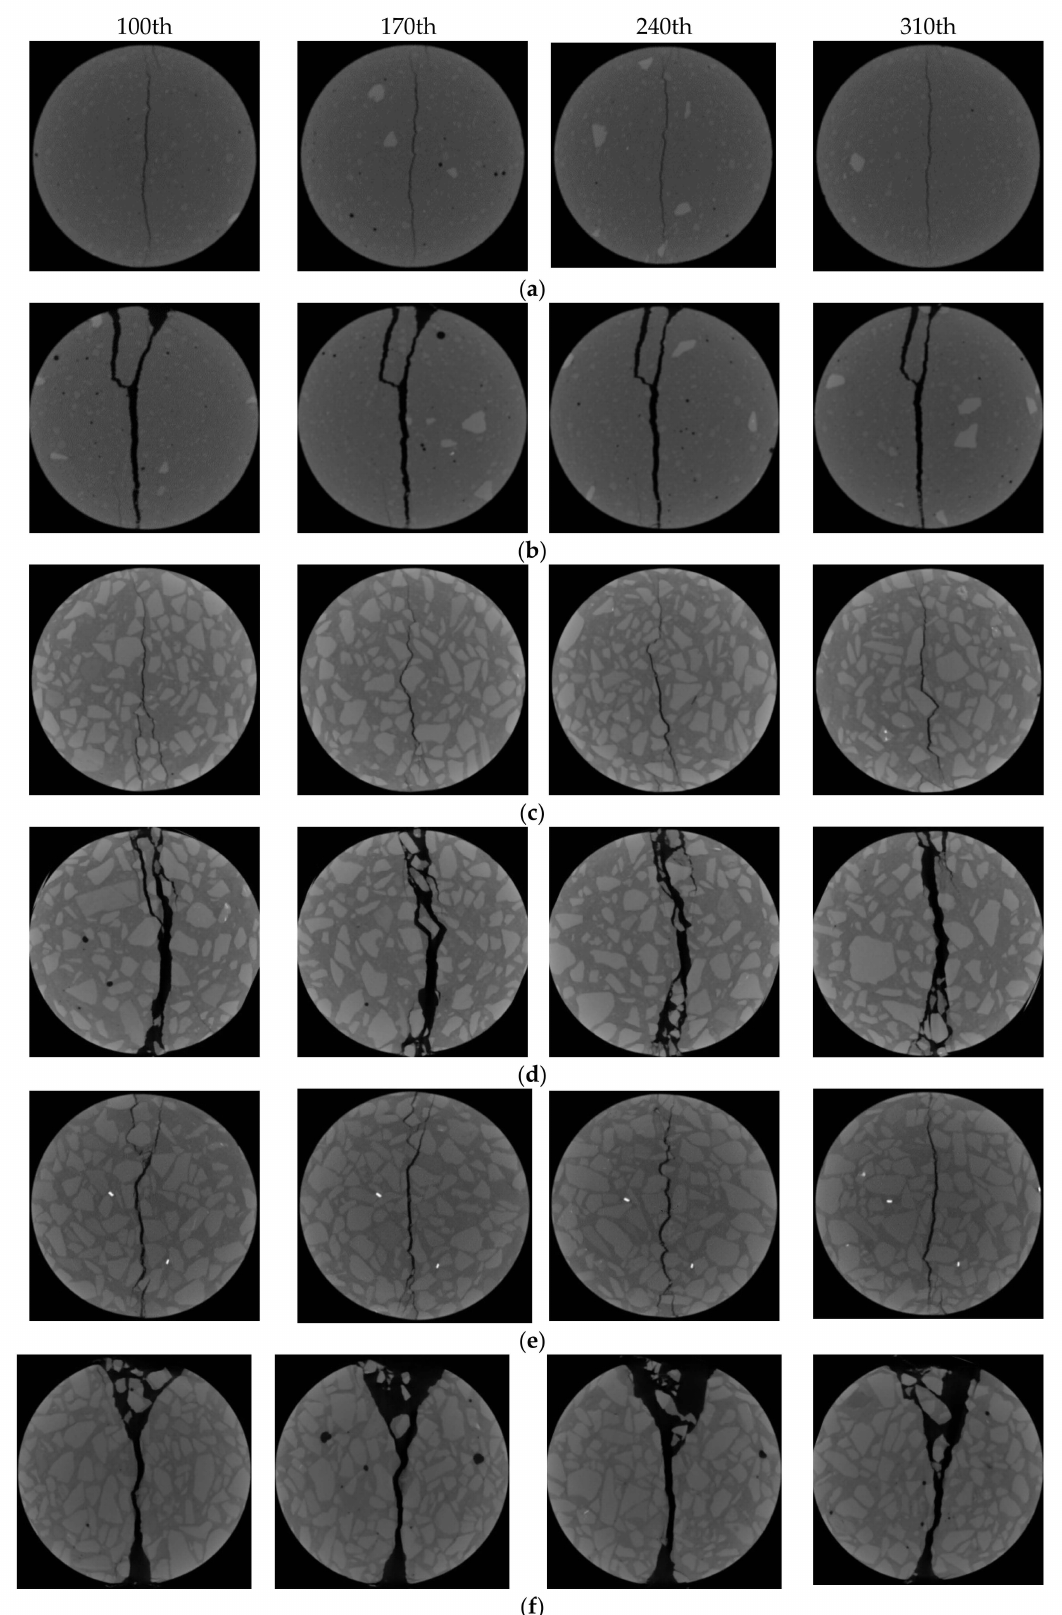
Figure 10. Typical slice images: ( a ) MA-02 m; ( b ) MA-2 s; ( c ) CA-02 m; ( d ) CA-2 s; ( e ) CC-02 m; ( f ) CC-2